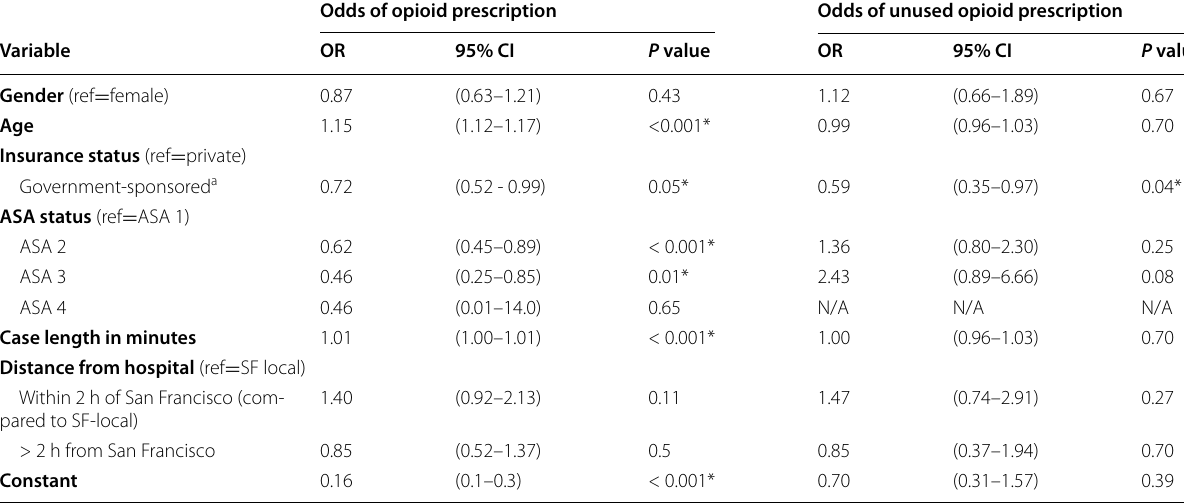
Abbreviations : ASA Status American Society of Anesthesiologists physical status rating, POD postoperative day, OR odds ratio, CI confidence interval